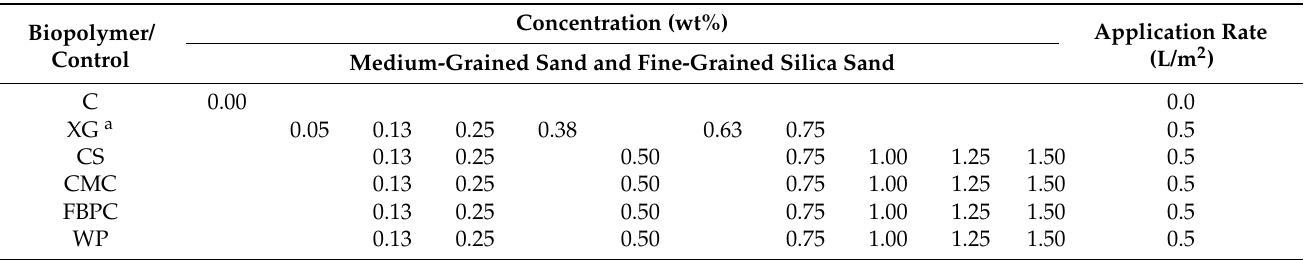
Table 1. Sample program of Phase 1, which investigated the effect of the biopolymer concentration on wind erosion resistance and crust penetration